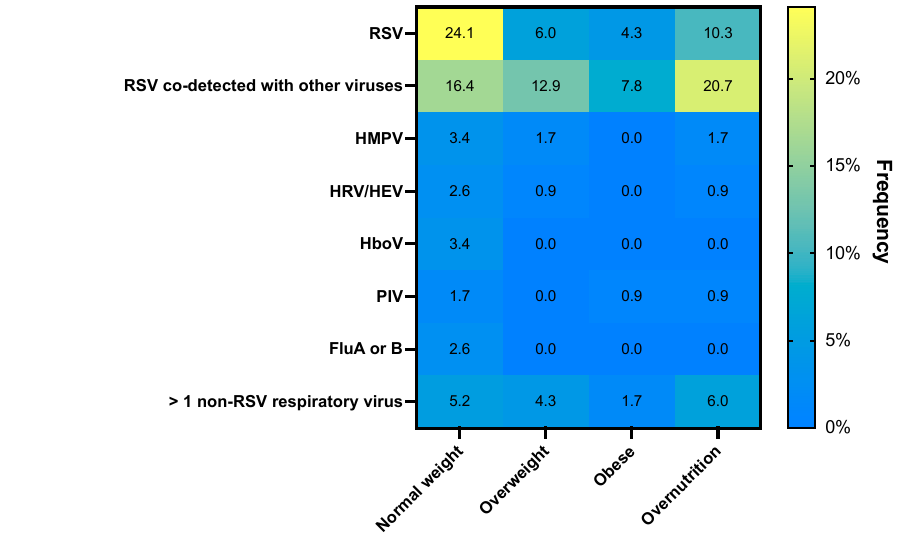
Figure 1. A two-dimensional heatmap showing the frequency of detection of the respiratory viruses both in mono-infection and co-infections according to patients’ nutritional status. RSV, respiratory syncytial virus; HMPV, human metapneumovirus; HRV/HEV, rhinovirus/enterovirus; HboV, bocavirus; PIV, parainfluenza virus; FluA, influenza A; FluB, influenza B.